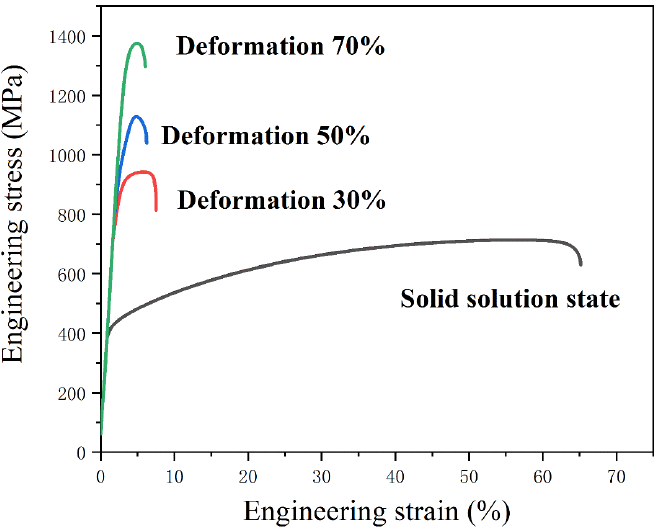
Figure 5. Engineering stress–strain curves of Fe-25Mn-3Si-3Al-0.3Nb steel before and after cold rolling. Table 2. Mechanical properties of Fe-25Mn-3Si-3Al-0.3Nb steel before and after cold rolling.